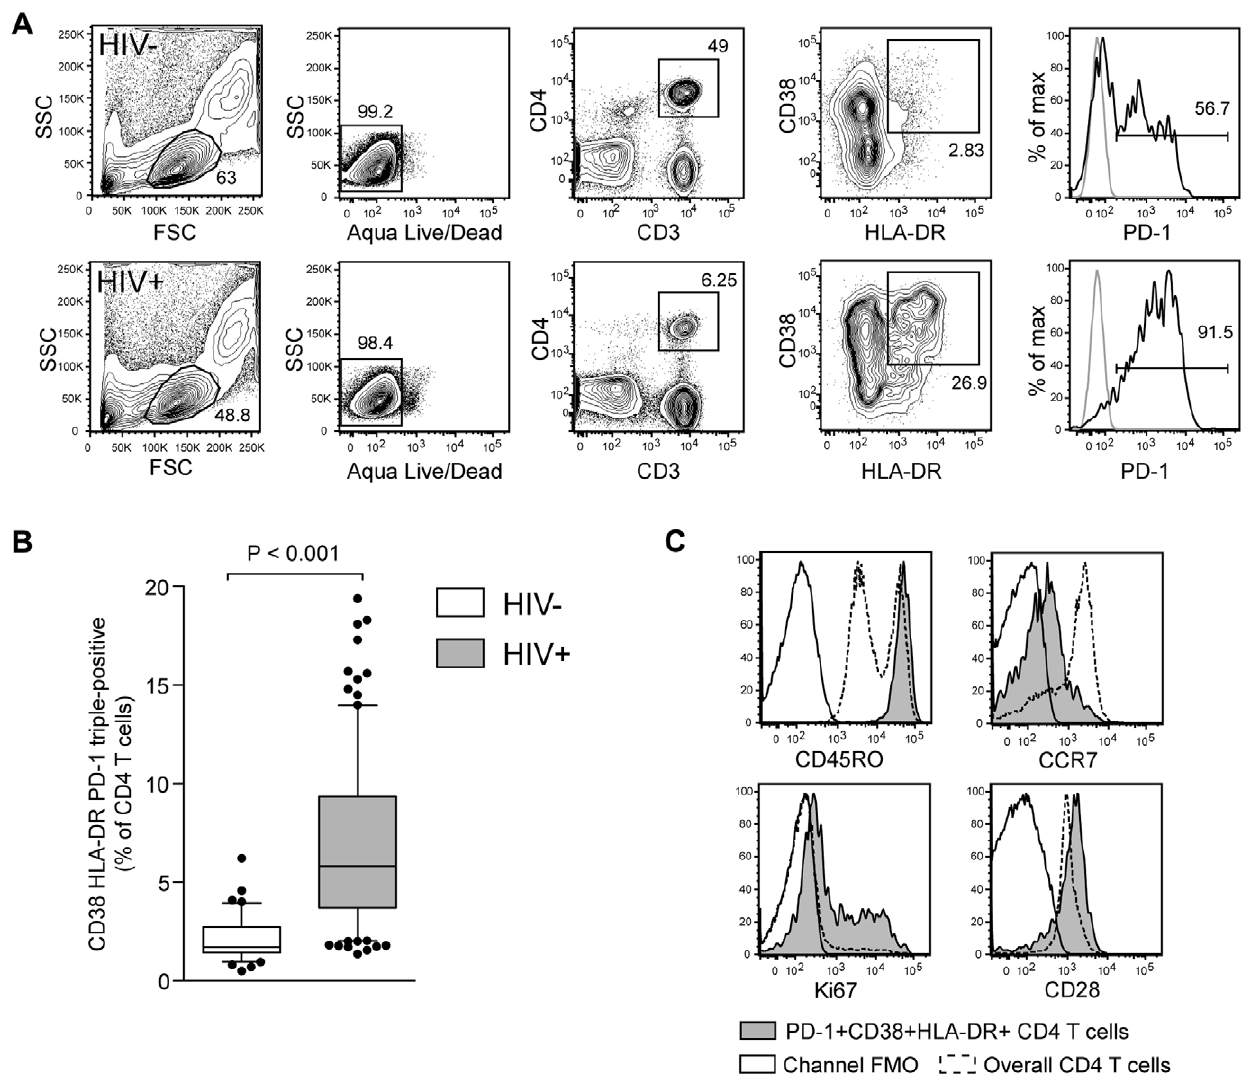
Figure 1. PD-1, HLA-DR, and CD38 together identify an effector memory CD4 T cell subset elevated in HIV-1 infection. (A) Identification of CD4 T cells co-expressing PD-1, HLA-DR and CD38 in HIV-1 infected and uninfected subjects. (B) Box and whisker plots showing the median and 10–90 percentile percentage of CD38, HLA-DR and PD-1 triple-expression in CD4 T cells in HIV negative (n=40) and HIV positive (n=103) subjects. (C) In order to assess the phenotype of the activated CD4 T cells, PBMC were analyzed by flow cytometry for the expression of CD45RO, CCR7, CD28, and Ki67. Filled line represents CD4 cells triple-positive for CD38, HLA-DR, and PD-1, while dashed line represents data from the overall CD4 compartment and empty filled line is the fluorescence minus one (FMO) control for that